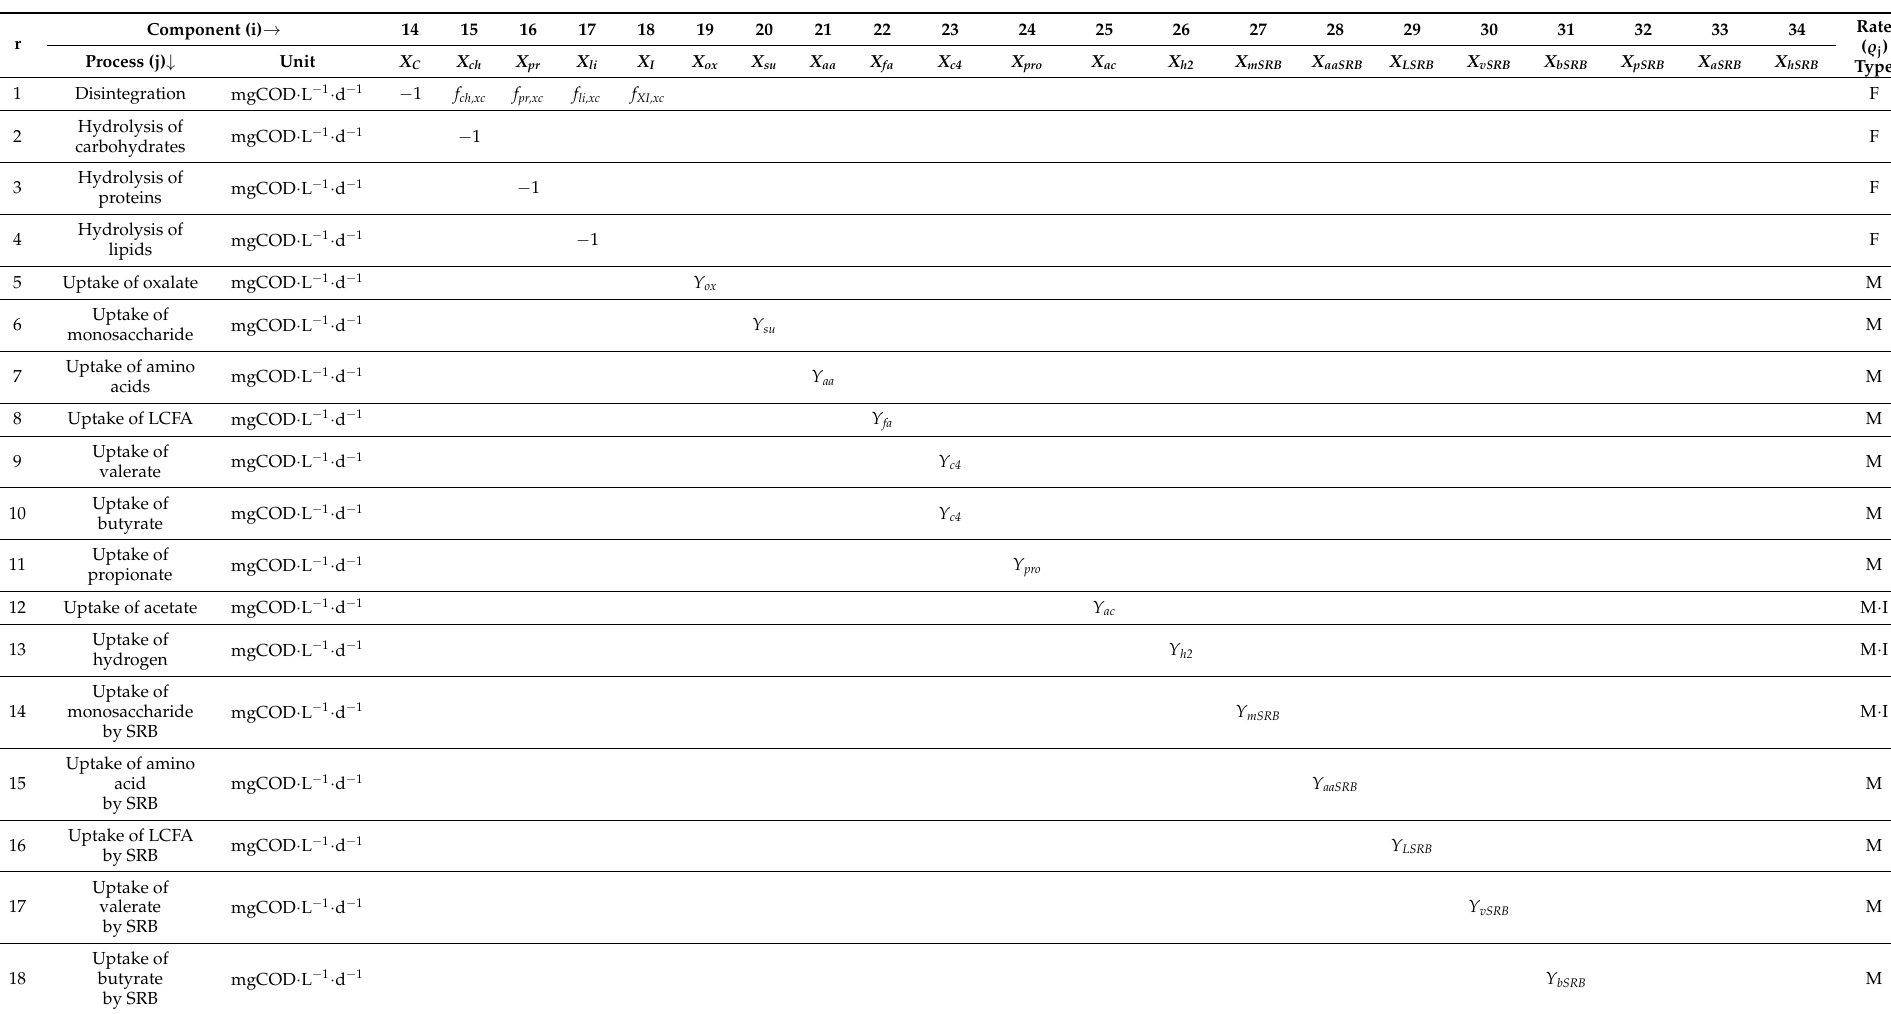
Table 3. Gujer matrix for the anaerobic fermentation model of salt-accumulating plants including sulfate reduction for particulate components (i = 14–34; j =